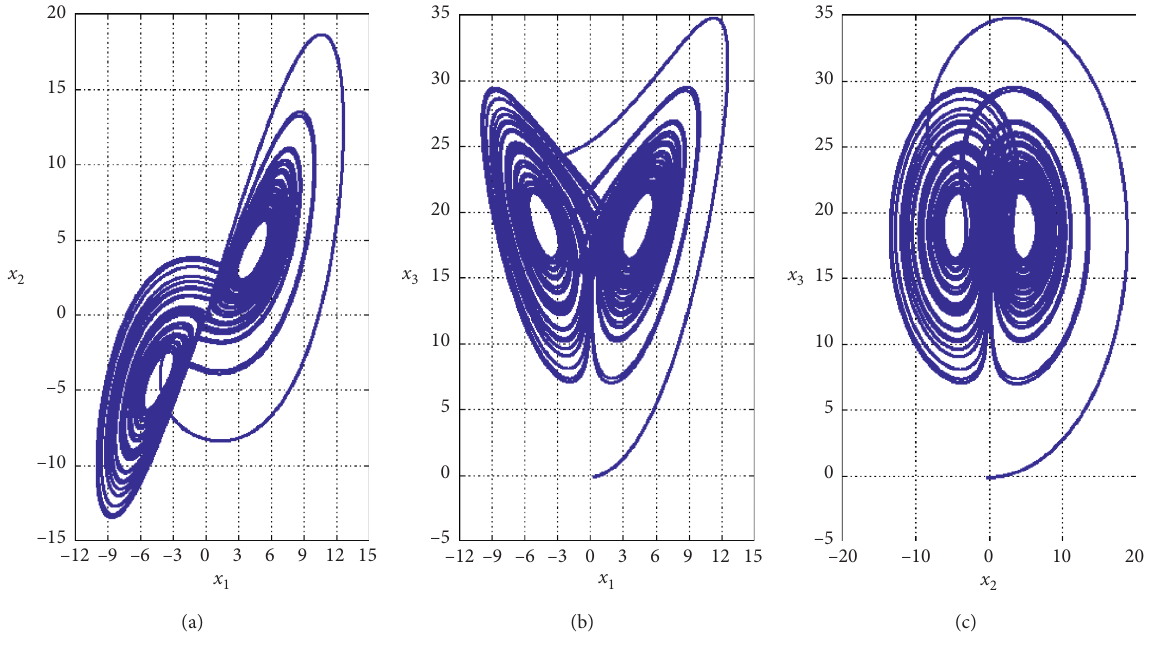
Figure 1: Two-dimensional portrait of Lorenz system